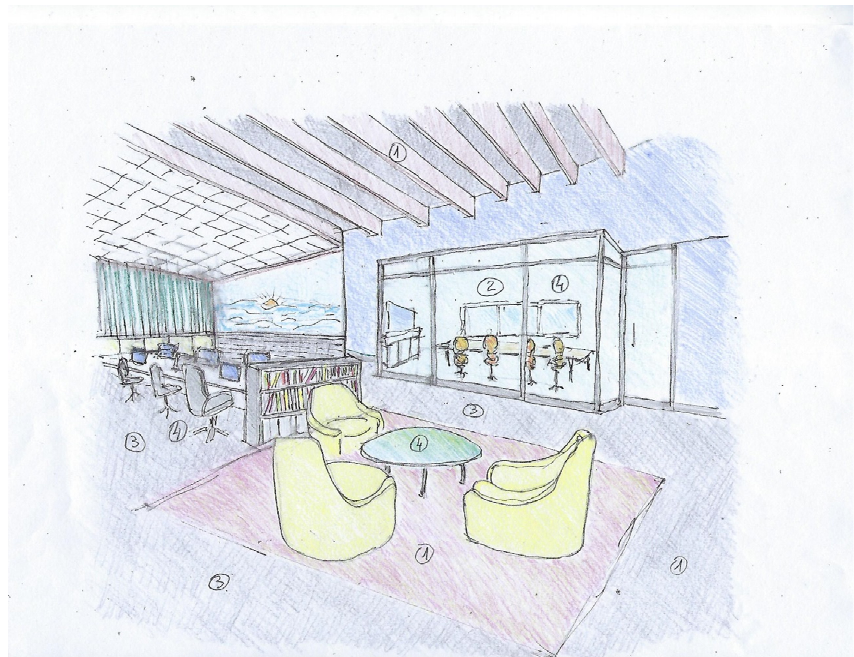
Figure 8. Sketch of an architectural design that illustrates relaxation spaces with acoustic carpets and ceilings ① , visual clearance ② , clear and simple circulation ③ , and different well-defined rest and work areas ④ .